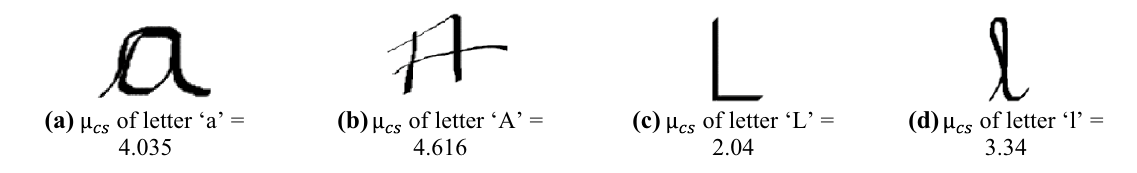
Fig. 7 Some examples of different handwritten letters with their 𝜇 cs values. a 𝜇 cs of letter ‘a’ = 4.035, b 𝜇 cs of letter ‘A’ = 4.616, c 𝜇 cs of letter ‘L’ = 2.04, d 𝜇 cs of letter ‘l’ = 3.34